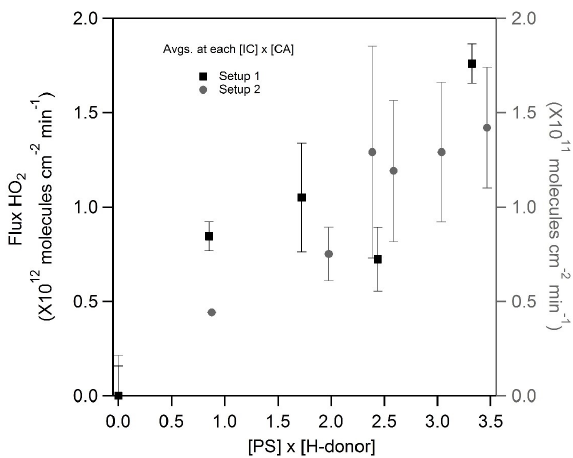
Figure 4. HO 2 fluxes in moleculescm − 2 min − 1 as a function of actinic flux for a 300–420nm range (solid symbols). The data are plotted as a concentration product of [IC] × [CA] (shown in the leg- end), which shows the photochemical reaction between IC and CA in H 2 O matrix and gaseous NO. HONO for 2.441 ([IC] × [CA]) is plotted on the right axis (open circles), showing a ratio of HONO:NO 2 < 1, which suggests OH as a secondary